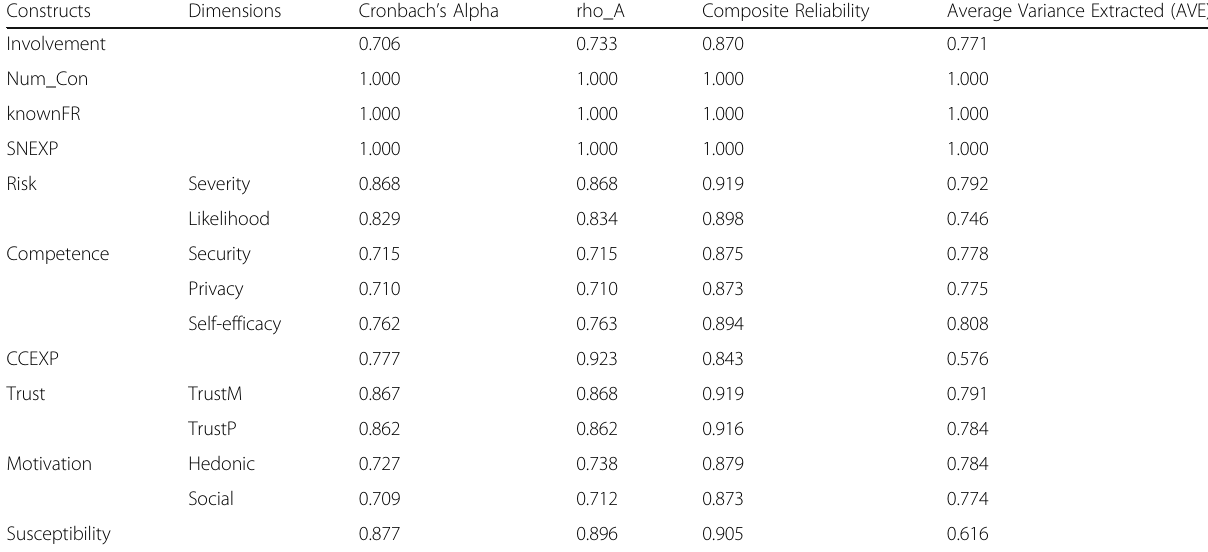
Table 2 Reliability and convergent validity tests Constructs